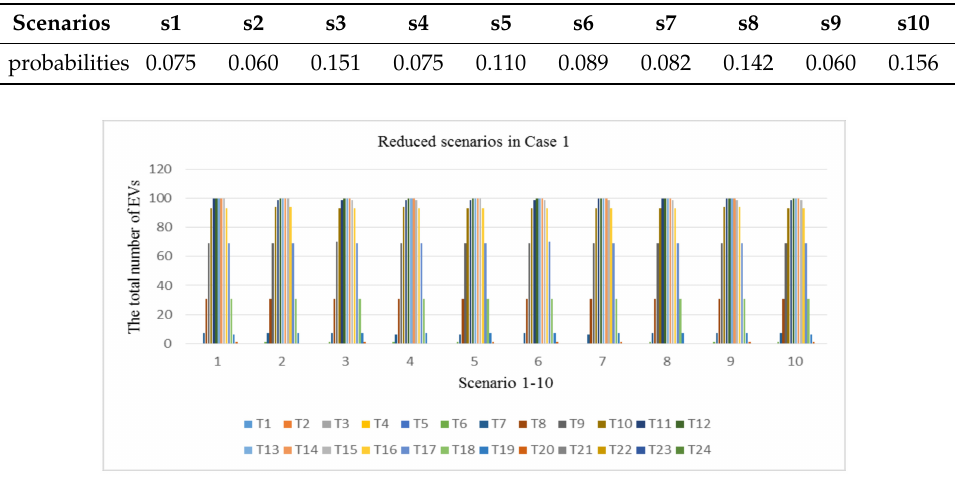
Figure 7. The reduced scenarios of total number of available EVs at each time instant in Case 1.